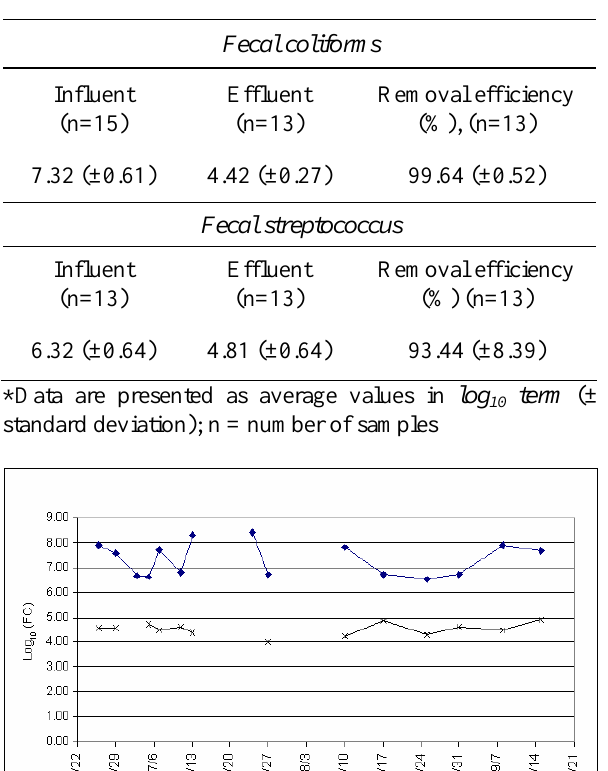
Table 1: Fecal coliforms and Fecal streptococcus in AWWTP influent and effluent*